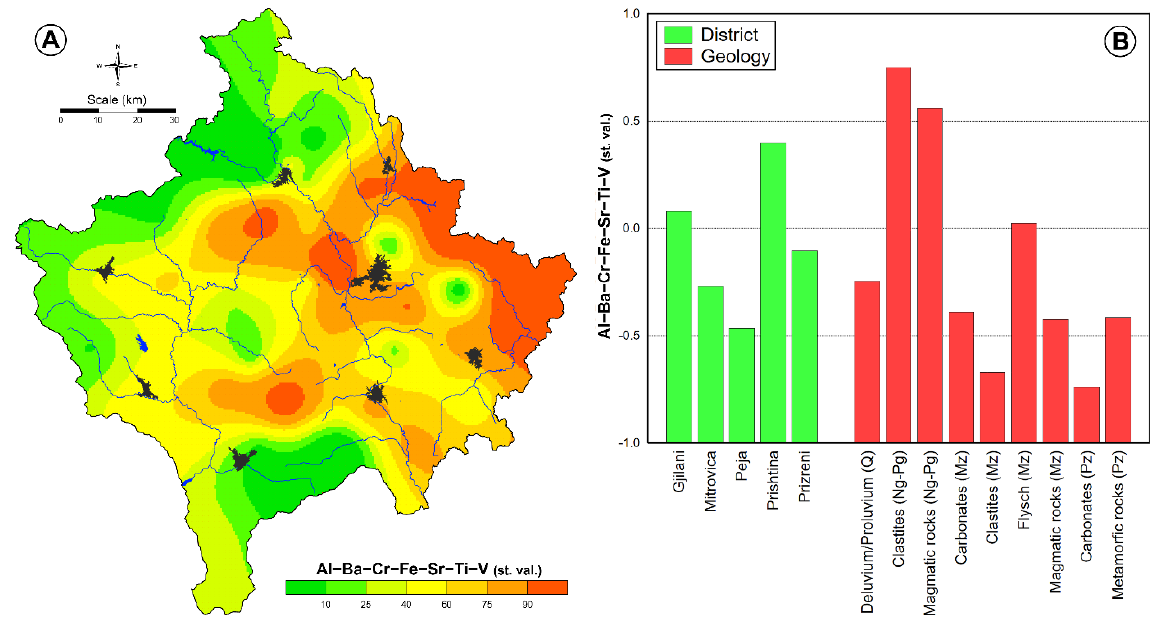
Figure 5. Spatial distribution of F1 factor scores ( A ) and distribution according to the districts and geological formations ( B ).